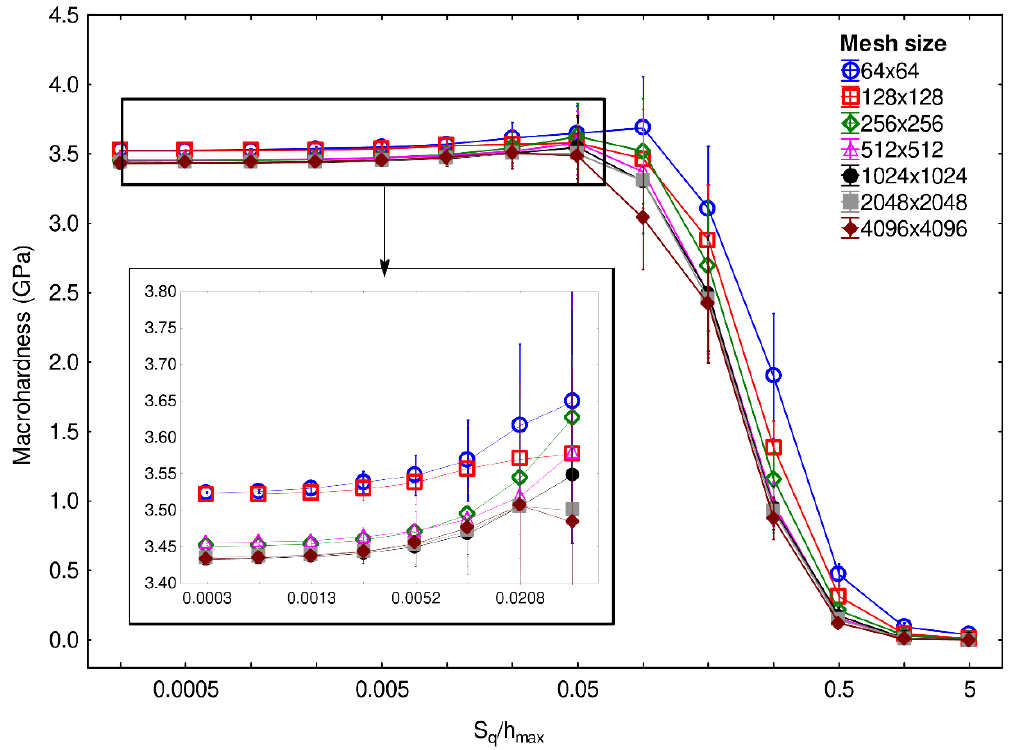
Figure 4. Macrohardness as a function of the ratio S q / h max , which is the root-mean-square roughness divided by the maximum indentation depth, computed with different mesh sizes. The wavelength and fractal dimension of the tested surfaces are, respectively, set to 32 µm and 2.5.